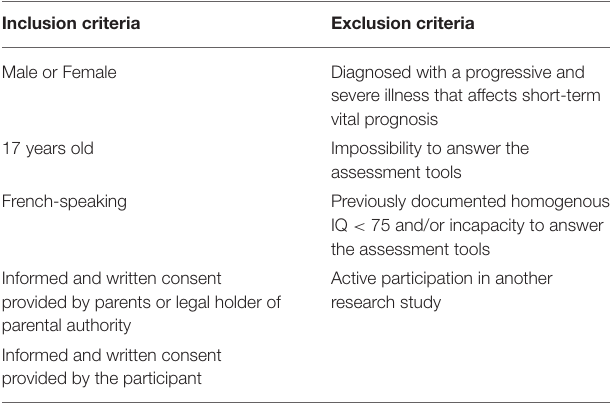
TABLE 1 | Eligibility criteria at